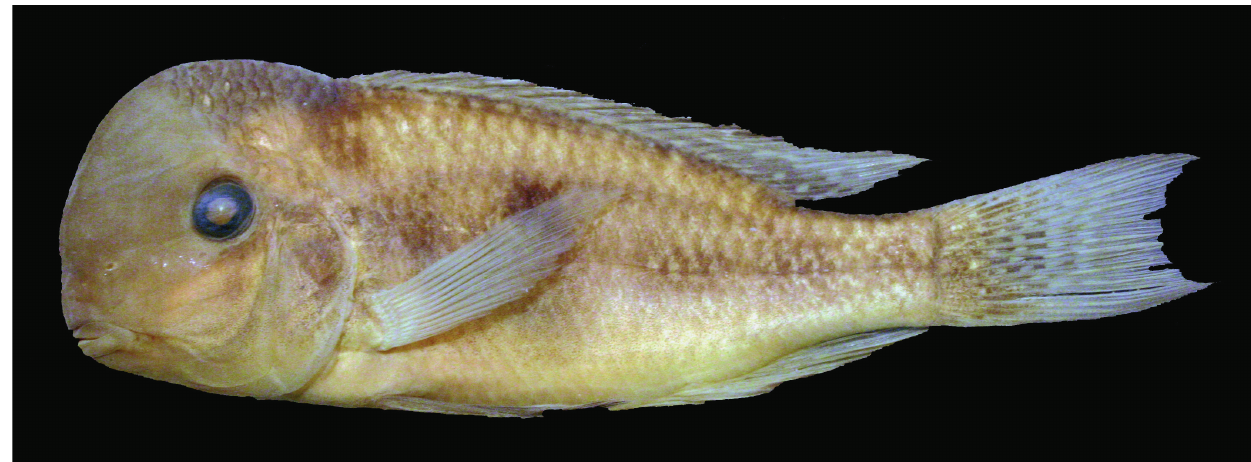
Fig. 1. Gymnogeophagus tiraparae , holotype, ZVC-P 7870, 99.7 mm SL, male, río Tacuarembó on Road 26, Pueblo Ansina, tributary to the río Negro (lower río Uruguay